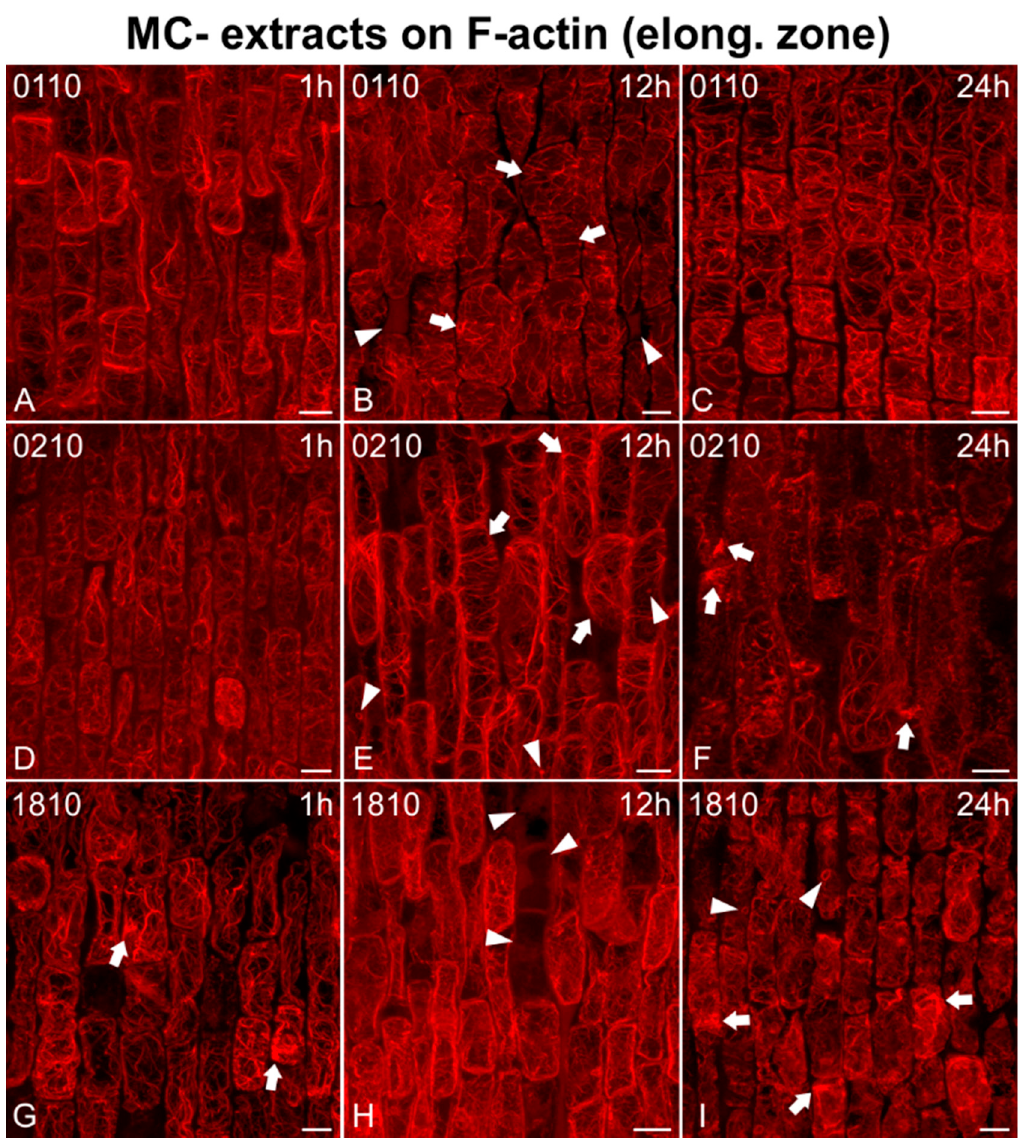
Figure 7. Maximum intensity projections of serial CLSM sections of Oryza sativa epidermal cells in the root elongation zone, stained for F-actin, after treatment with MC − extracts from various non-MC-producing strains: Jaaginema sp. TAU-MAC 0110 ( A – C ), Jaaginema sp. TAU-MAC 0210 ( D – F ), and Microcystis viridis TAU-MAC 1810 ( G – I ). Root tips in all images point towards the bottom of the page. Actin cables were not significantly a ff ected after 1 h of treatment ( A , D ), except for some actin aggregates (arrows in G ). After 12 h, F-actin disorientation was visible (arrows in B , E ), along with actin rings (arrowheads in E ) and cells devoid of F-actin (arrowheads in B , H ). After 24 h, actin rings were still detectable (arrowheads in I ), as well as disorientation ( C ) and actin aggregates (arrows in F , I ). Scale bars: 10 µ